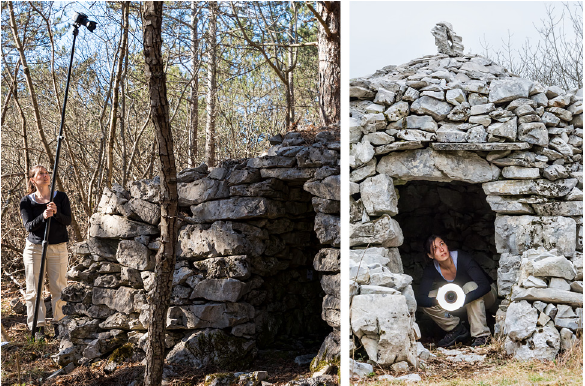
Figure 2. Photographing dry-stone shelters using a photographic pole (HIS_043) and artificial illumination